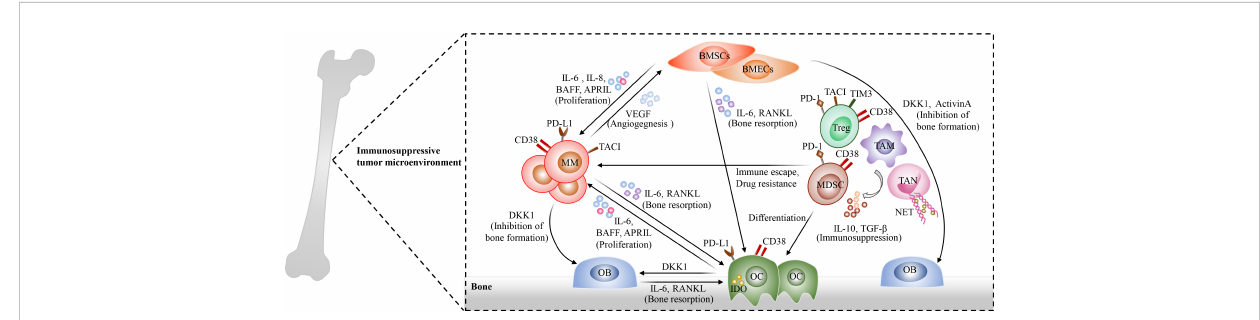
FIGURE 2 The complexity of bone marrow microenvironment in MM. Multiple immunosuppressive cells are accumulated in bone marrow microenvironment and exhibit tumor supportive properties, including osteoclasts (OCs)such as osteoclasts (OCs), myeloid-derived suppressor cells (MDSCs), regulatory T cells (Tregs), regulatory B cells(Bregs), tumor-associated macrophages (TAMs), tumor-associated neutrophils (TANs), and bone marrow stromal cells (BMSCs). These cells interact with surrounding MM cells through direct cell-to-cell contact or producing soluble factors, and then promote the proliferation, immune escape of MM cells as well as Drug resistance. Osteoclasts (OCs) are remarkably increased in the bone marrow microenvironment of MM patients and involved in the occurrence and development of myeloma bone disease. In addition, they produce APRIL, BAFF and IL-6 to promote MM cell proliferation and survival. Meanwhile, OCs act as antigen-presenting cells (APCs) in the bone marrow and exhibit immunosuppressive properties through up-regulating the expression of immune checkpoint molecules, such as PD-L1, CD38 and galectin 9. In turn, MM cells could promote bone resorption activity of OCs through the secretion of IL-6 and RANKL. Immunosuppressive Tregs and MDSCs, which express several immune inhibitory molecules, such as PD1, TIM3, and CD38, are signi fi cantly increased in MM bone marrow microenvironment and secrete TGF- b and IL-10 to promote the evasion of MM cells from immune surveillance. TAMs apparently in fi ltrate the bone marrow, and they promote angiogenesis and induce immune escape and drug resistance of MM cells. In addition, TANs also play an immunosuppressive role in MM bone marrow microenvironment through the release of neutrophil extracellular traps (NETs), which could contribute to tumor-associated thrombosis and tumor metastasis. Moreover, BMSCs show an in fl ammatory phenotype in MM microenvironment. On the one hand, they